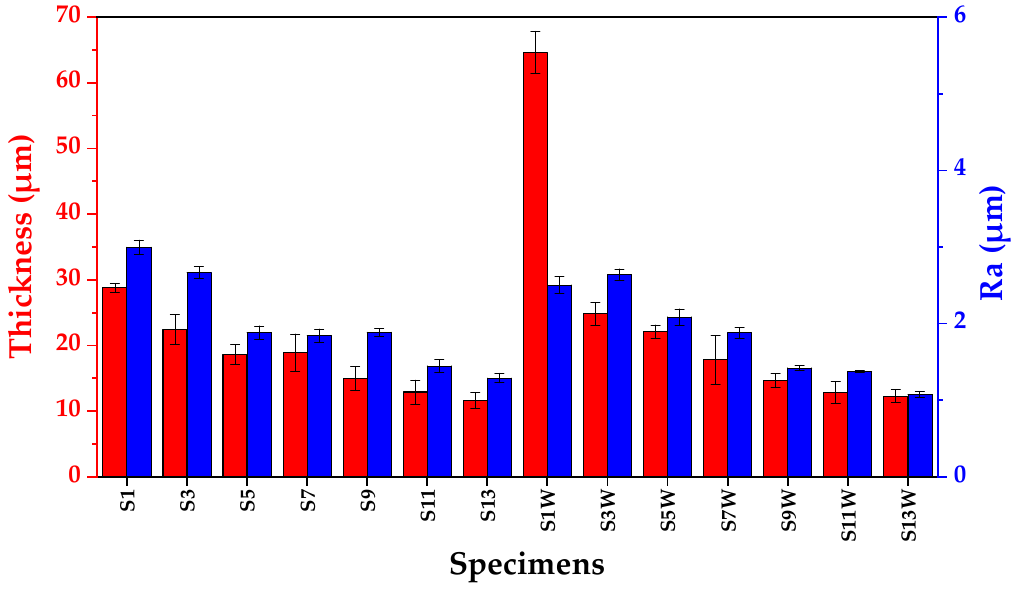
Figure 12. The average surface roughness and average thickness values of the PEO coatings (The red curve is related to the average thickness, and the blue curve is related to the average surface roughness (Ra)).